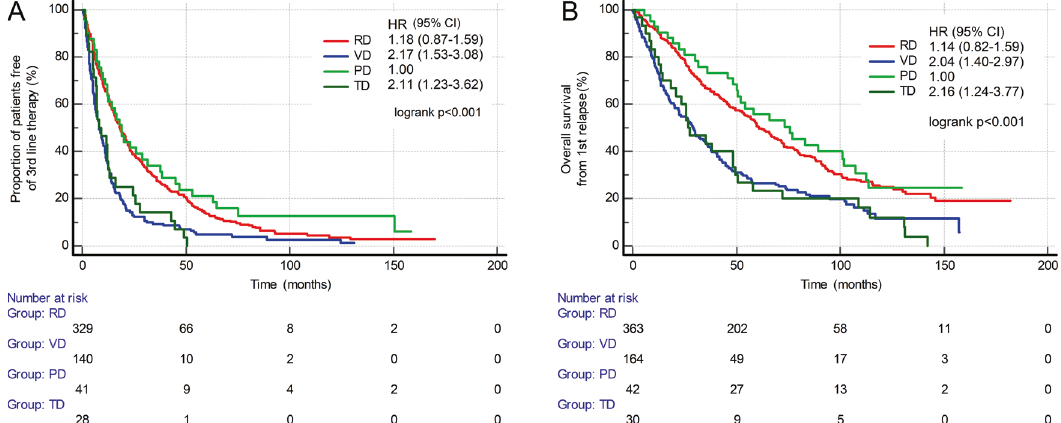
Fig. 4 Comparisons of most frequently used doublet regimens on post-progression survival. A Time to next treatment from fi rst relapse (TTNT). B Overall survival from fi rst relapse (OS). CI con fi dential interval, HR hazard ratio, PD pomalidomide-dexamethasone, RD lenalidomide- dexamethasone, TD thalidomide-dexamethasone, VD